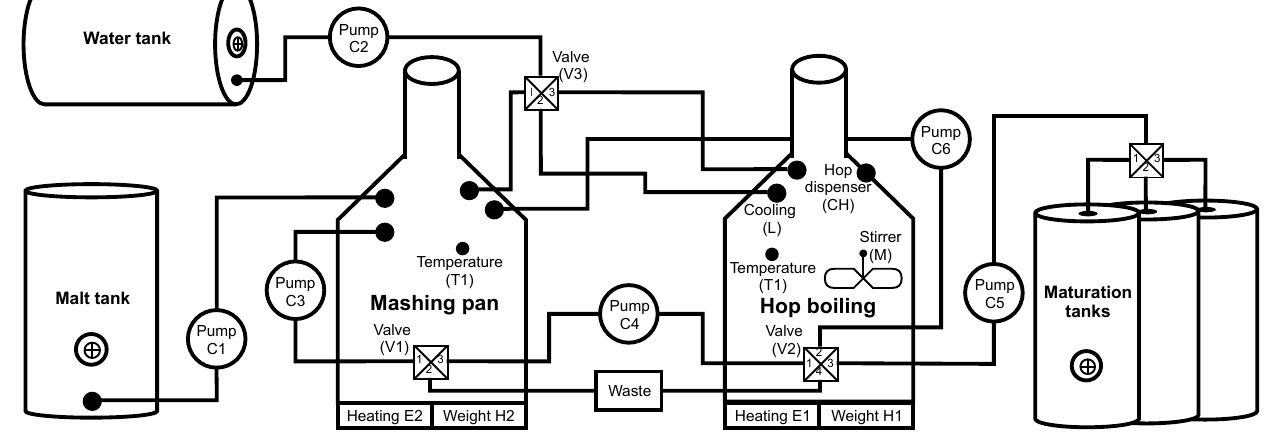
Figure 11. Diagram of the simulated brewery